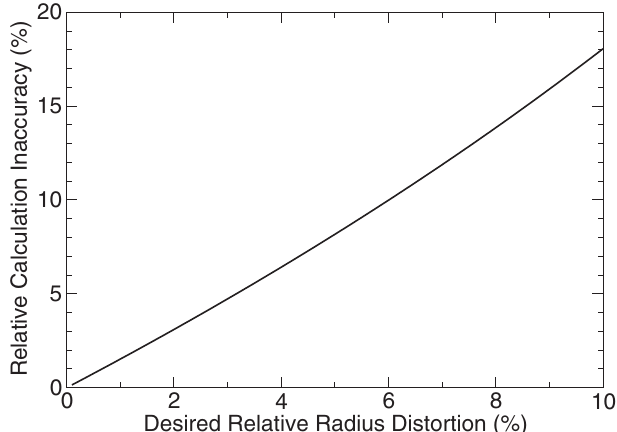
FIG. 10. Relative inaccuracy in the calculation of (cid:1) J vs the desired value of (cid:1) J=J , for the boundary distortion without the amplitude-dependent linear